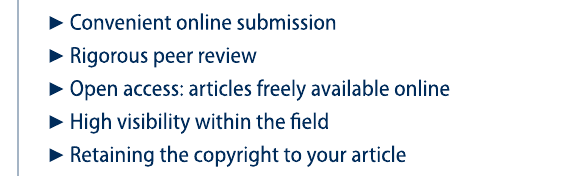
48. Service Measurement Index (SMI) Measures Definitions (2014) Available at: http://csmic.org/downloads/SMI_Measures_Version_TwoPointOne.zip 49. Feuless S (2016) The cloud service evaluation handbook: how to choose the right service, CreateSpace Independent Publishing Platform 50. Feuless S (2016) Sample Scored Framework (2014): available at https:// cloudserviceevaluation.files.wordpress.com/2016/06/sample-scored- framework-bw.xlsx 51. Nielsen J (2006) Quantitative Studies: How Many Users to Test? Available at: